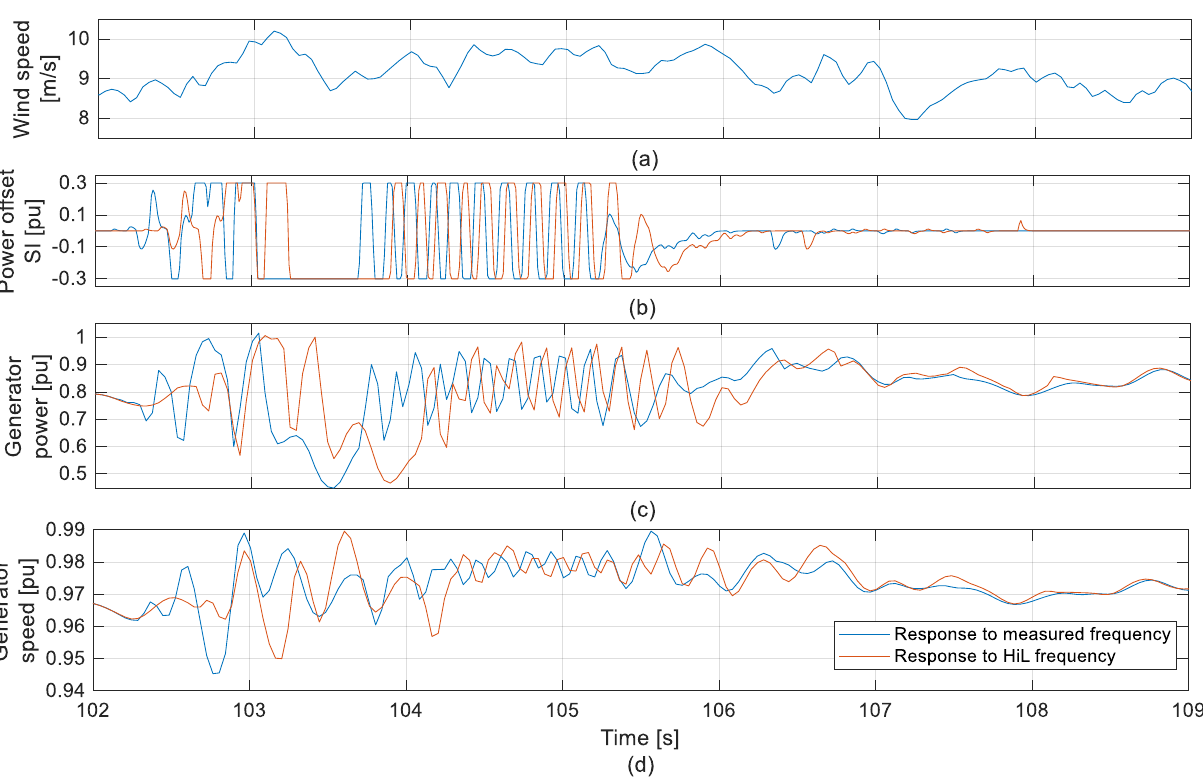
Figure 12. WTG reaction to scenario 10 for the measured frequency (blue) and the HiL frequency. ( a ) Wind speed, ( b ) power offset for SI provision, ( c ) generator power and ( d ) generator speed. Time axis of ( d ) is valid for the above subplots as well.